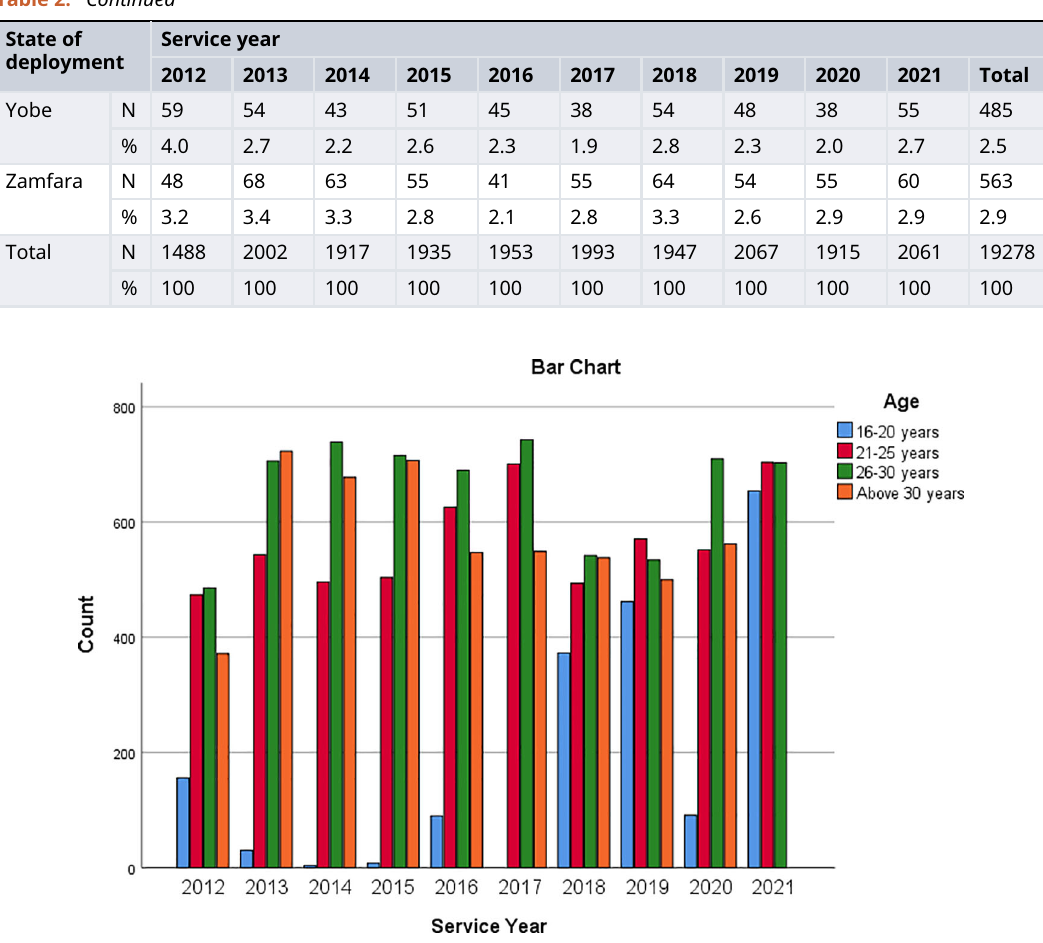
Figure 1. Bar chart showing respondents ’ age based on service year.